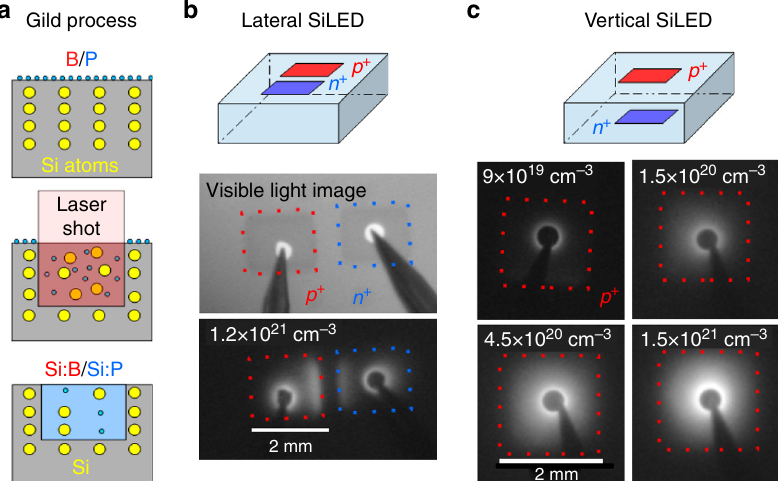
Fig. 1 Silicon light-emitting diodes from gas immersion laser doping (GILD). a Schematics of the GILD doping process: chemisorbtion of the dopant gas (PCl 3 /BCL 3 ); laser melting of the bulk Si and dopant incorporation in the liquid phase; Si:P or Si:B crystal epitaxy during solidi fi cation. b Schematic of lateral devices and infrared images of a silicon light-emitting device (SiLEDs) (1.2 × 10 21 cm − 3 ) biased at 20 mA and at room temperature. c Schematic of vertical devices and infrared images of SiLEDs biased at 20 mA at room temperature for different doping levels (9 × 10 19 , 1.5 × 10 20 , 4.5 × 10 20 , 1.5 × 10 21 cm − 3